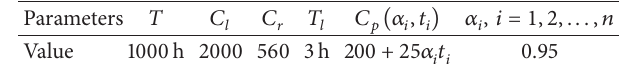
Table 3: Parameter setting. Table 4: Optimization